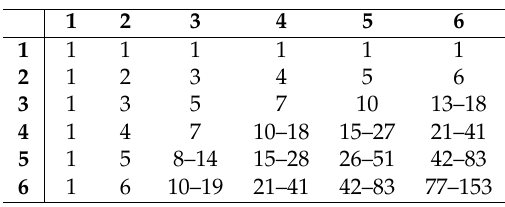
Table 2. Ranges for r m ax ( n , d ) in low